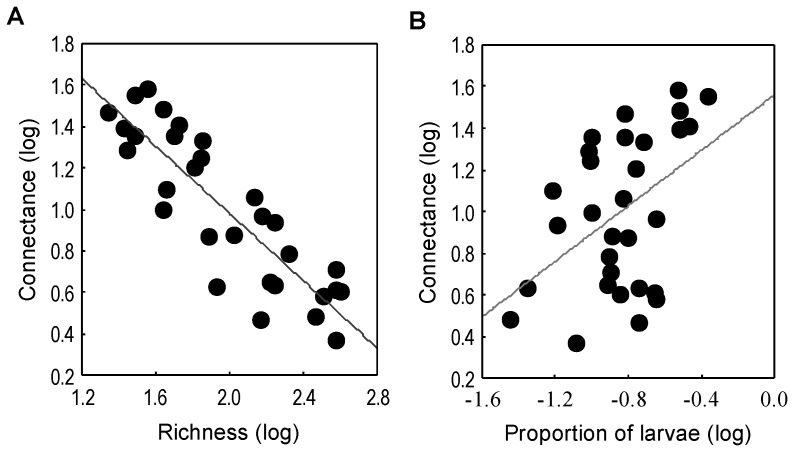
Correlations between the parameters calculated for 30 fish-parasite networks.The relationship (a) between species richness and connectance, showing that species-rich networks have a low connectance, and (b) between the proportion of parasite species at the larval stage and connectance, evidencing the contribution of this stage to an increase in connectance.